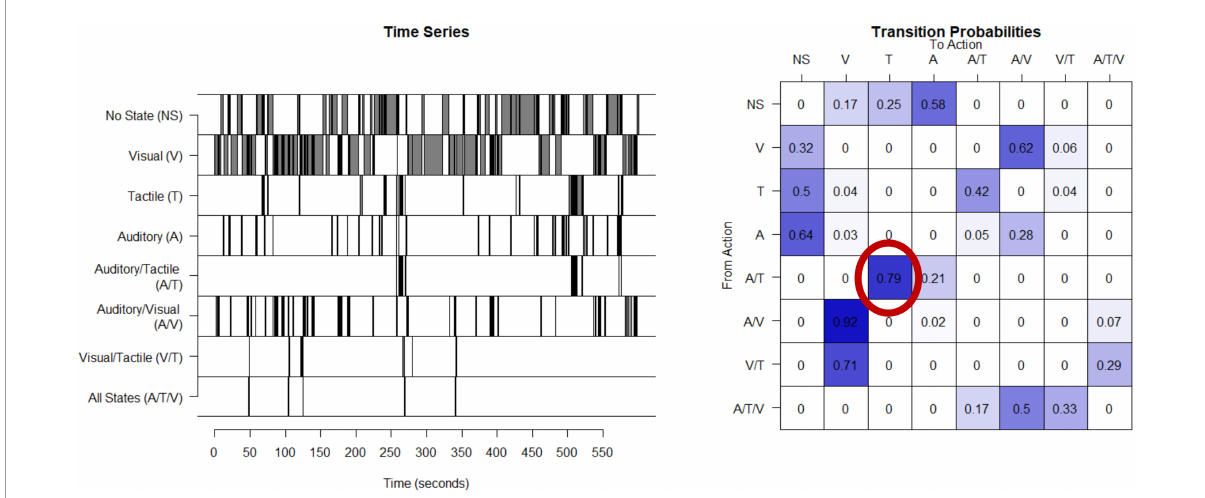
FIGURE1 Calculation of entropy rate in humans: This time series shows the eight possible states for one example mother given the three types of sensory signals. This timeseries is then used to compute a transitional probability matrix. This matrix shows the percent of times a mother transitions from one state to another. For example, as shown in the probability matrix, 79% of the time when this mother was providing auditory and tactile at the same time, she then transitions to providing only tactile.